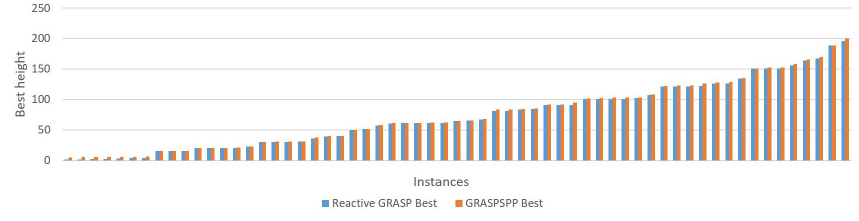
Figure 15. Best values comparison between GRASPSPP and reactive GRASP, part 1.